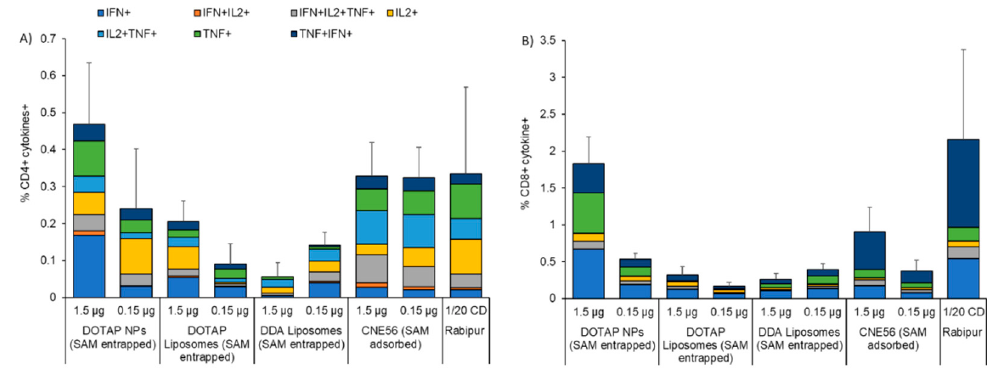
Figure 5. Percentages of antigen-specific CD4 + or CD8 + T-cells. Splenic ( A ) CD4 + T cells, and ( B ) CD8 + T-cells 2 weeks after two intramuscular immunizations spaced 4 weeks apart in BALB/c mice. Mice were immunized with either 1.5 or 0.15 µg/dose of self-amplifying RNA expressing rabies G glycoprotein adjuvanted with either polymeric nanoparticles (NPs), DOTAP liposomes or DDA liposomes, and spleens from 3 mice randomly selected out of the group were tested. Candidates were compared with the commercial vaccine Rabipur (1/20 of human dose) and GSK trademark CNE56 as positive controls. Splenocytes were stimulated with rabies G1/G2/G3 peptide, stained for intra- cellular cytokines, and analyzed by flow cytometry. The color code indicates the different combinations of cytokine produced by the respective cells. Unstimulated cells were used as control. Refer to Figure S3 in the Supplemental Material for the gating strategy.